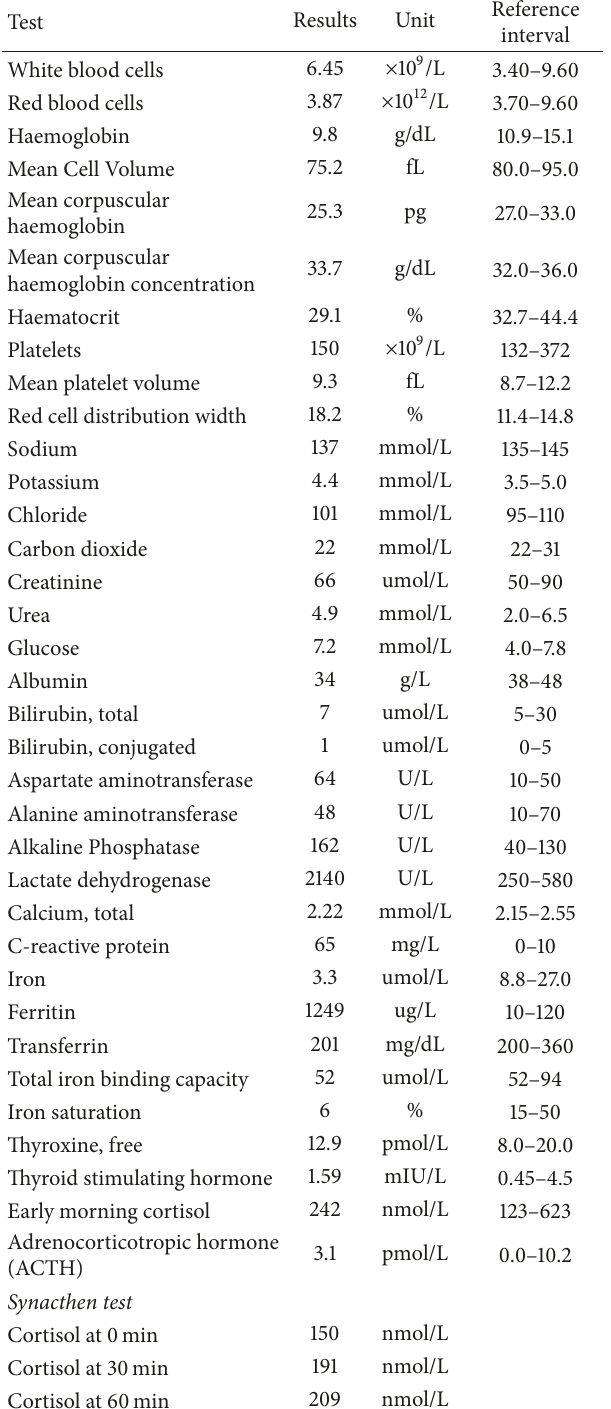
Table 1: Initial blood test results.